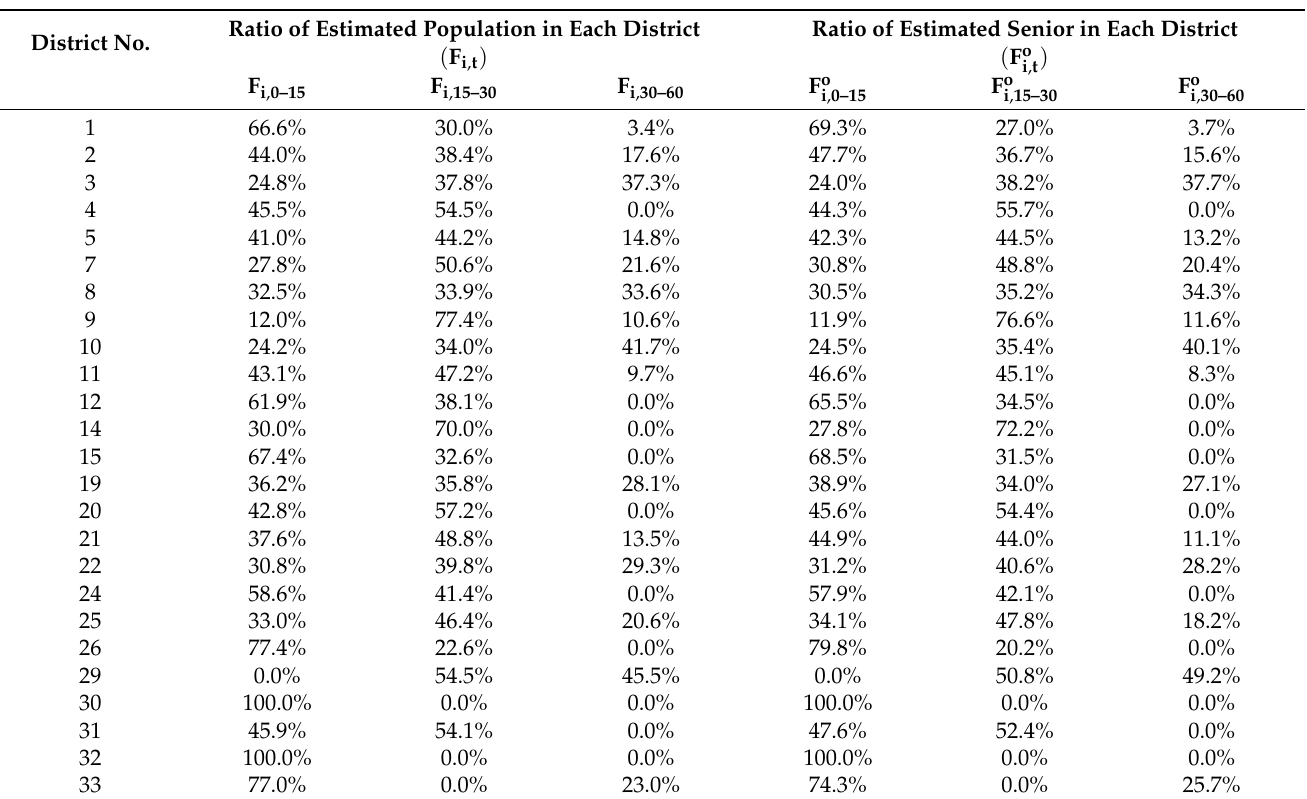
Table 5. Accessibility of each district to access healthcare facilities within time period t, distinguished by the ratios of estimated population and senior